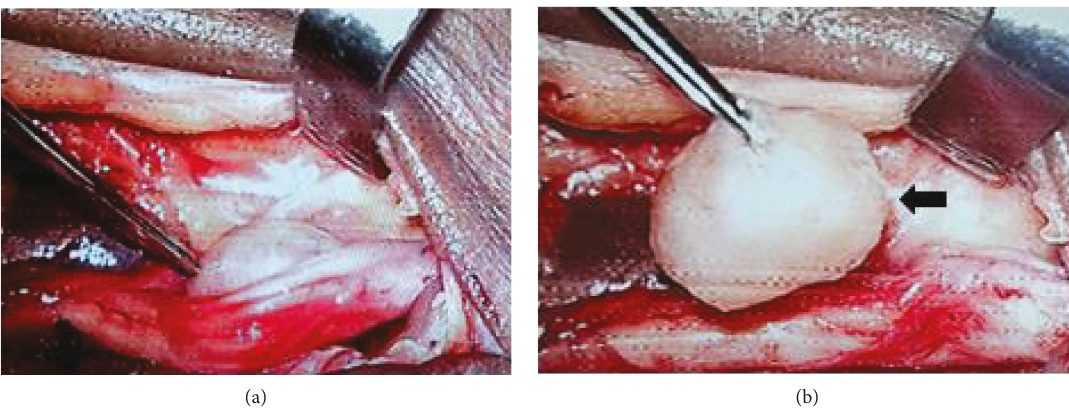
Figure 2: Intraoperative images (a, b) showing excision of the mass which was engulfed in the posterior tibial nerve as seen through the microscope which was used to assist excision.